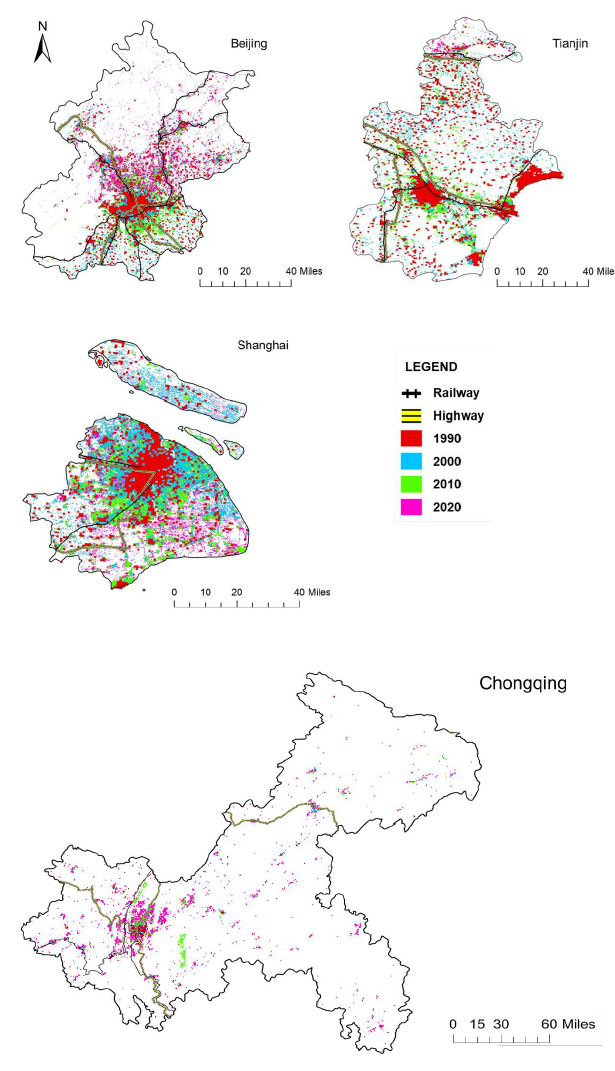
Figure 4 . New construction land changes in major years.